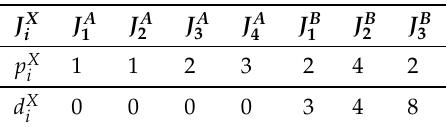
Table 1. The job instance I 1